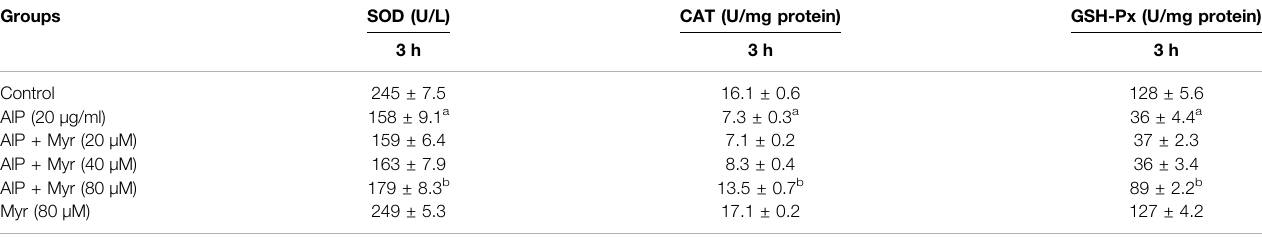
TABLE 1 | Effects of AlP at concentration 20 μ g/ml and Myr at concentrations of 20, 40, and 80 µM + AlP on superoxide dismutase (SOD), catalase (CAT), and glutathione peroxidase (GSH-Px) levels of rat heart isolated cardiomyocytes at 3 h.